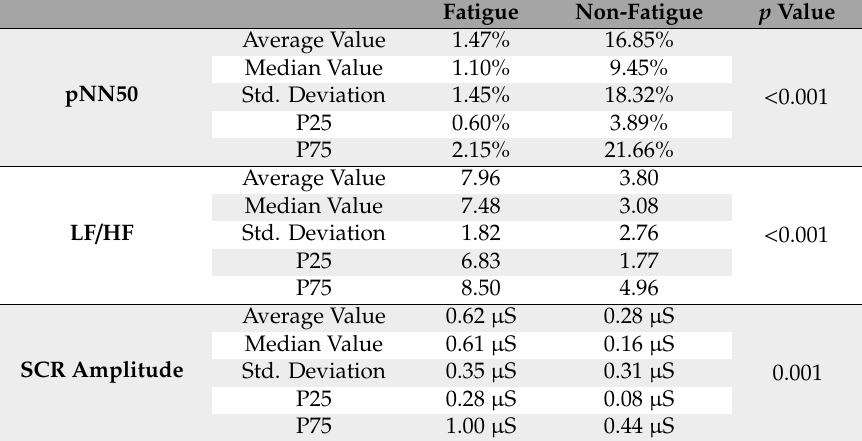
Table 10. Heart rate variability and skin conductivity during driving test grouped by tiredness level.